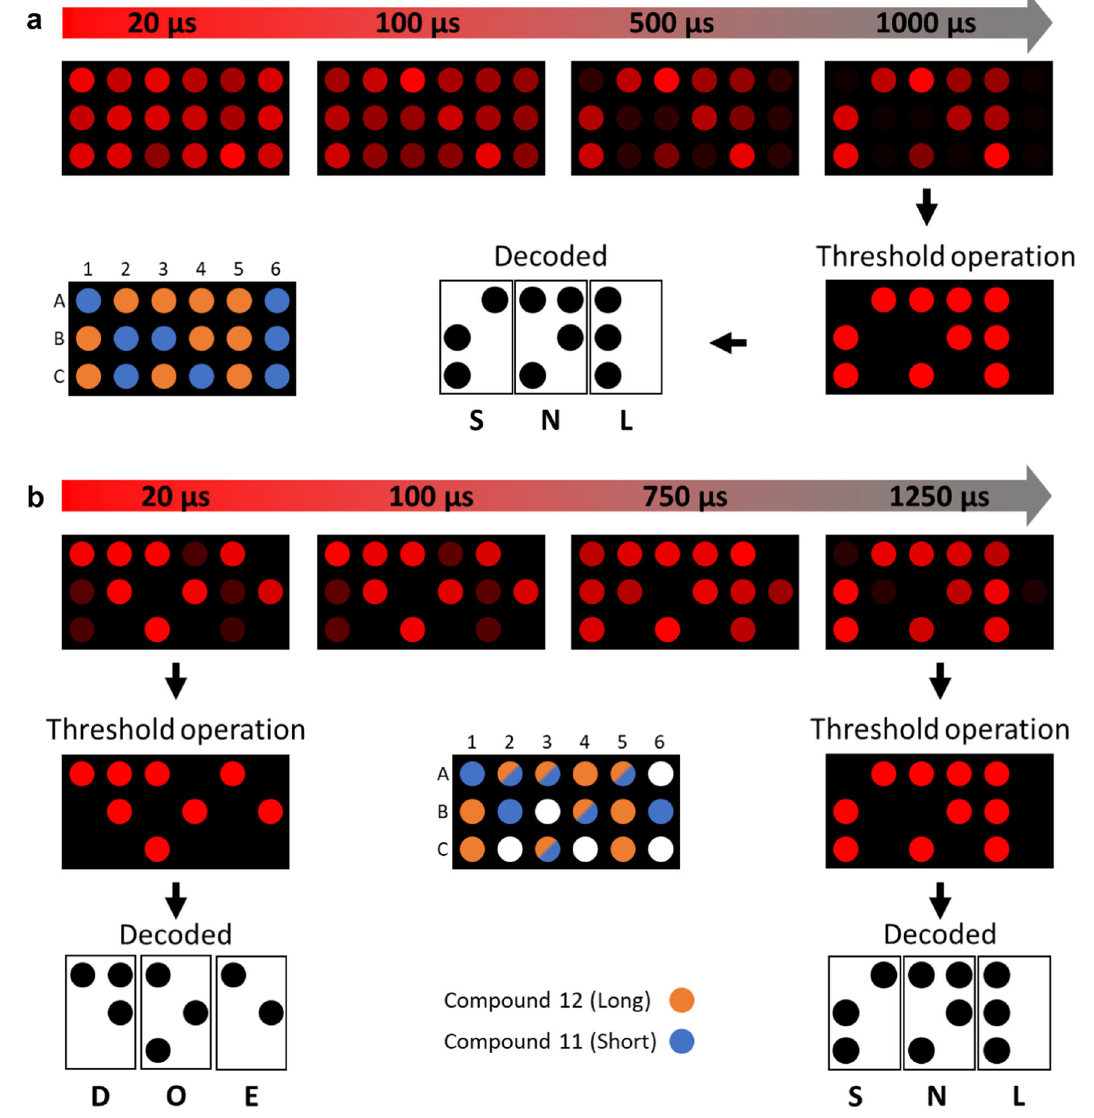
Fig.6|Representationofanencodedmessageutilizingthebraillealphabetina 96-wellplate.a Adynamictagthatshowsthetransitionfromundifferentiateddots to the message over time based on different compound lifetimes. b A double- encodeddynamictagthatshowsaninitialencodingbasedonemissionintensityvia